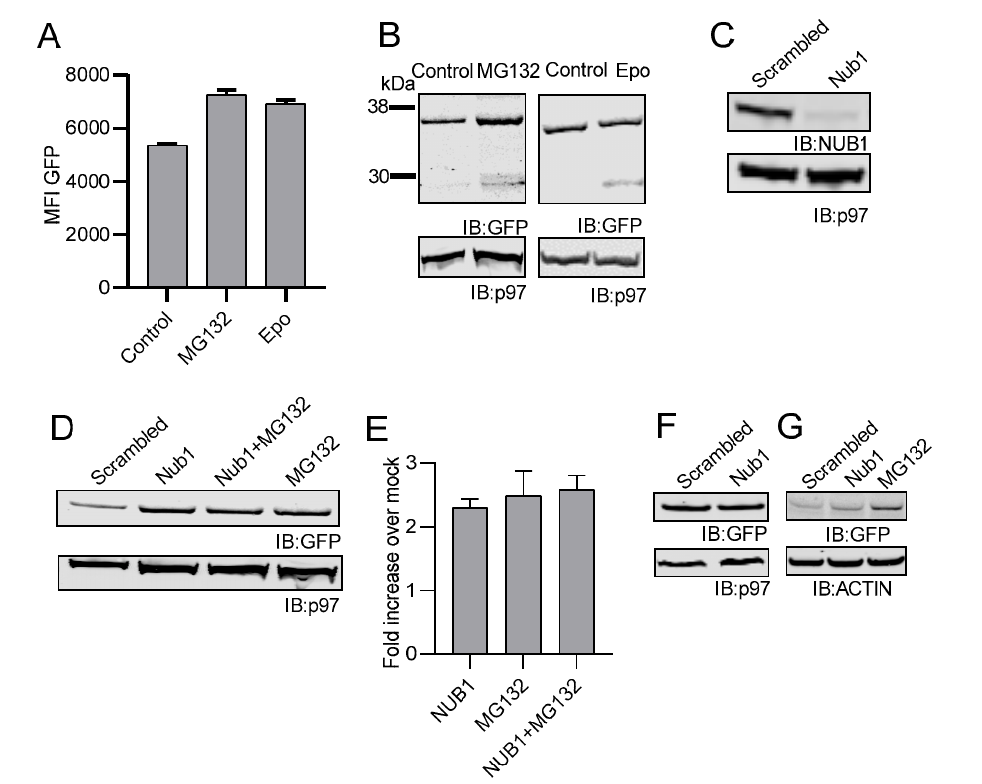
Figure 3. Non-cleavable NEDD8-GFP undergoes proteasomal degradation in a NUB1-dependent process. EL4 cells stably expressing NC NEDD8-GFP were treated with the proteasomal inhibitors MG132 or epoxomicin (epo) for 3 h and checked for NEDD8-GFP accumulation. ( A ) Flow cytometric analysis for GFP fluorescence of cells after proteasomal inhibition are compared with mock-treated cells as a control. The MFI of GFP for the total cell population is reported on the y -axis. ( B ) Cell lysates of EL4/NC NEDD8-GFP cells treated with MG132 or epoxomicin were made and analyzed by Western blot using mouse monoclonal antibodies against GFP and p97 with appropriate secondary antibodies. ( C ) Western blot analysis of EL4/NC NEDD8-GFP cells transfected with either scrambled siRNA oligomers or siRNA targeting NUB1. Cell lysates were probed for either NUB1 (top panel) or p97 as a loading control (bottom panel). ( D ) EL4/NC NEDD8-GFP cells were transfected with scrambled or NUB1-targeting siRNAs and cultured with or without MG132. Cell lysates were examined by Western blot analysis for GFP. ( E ) GFP signal obtained by Western blot was quantified in three independent experiments and calculated as fold-increase over mock-treated cells. Error bars represent the standard error. ( F ) GFP levels were analyzed by Western blot analysis in EL4/NEDD8-GFP cells upon NUB1 loss. ( G ) EL4/SCRAP cells were transfected with NUB1-specific or scrambled siRNAs are analyzed by Western blot for GFP. As a control, EL4/SCRAP cells transfected with scrambled siRNAs were treated with MG132 prior to cell lysis. All Western blot images were cropped to show relevant bands.